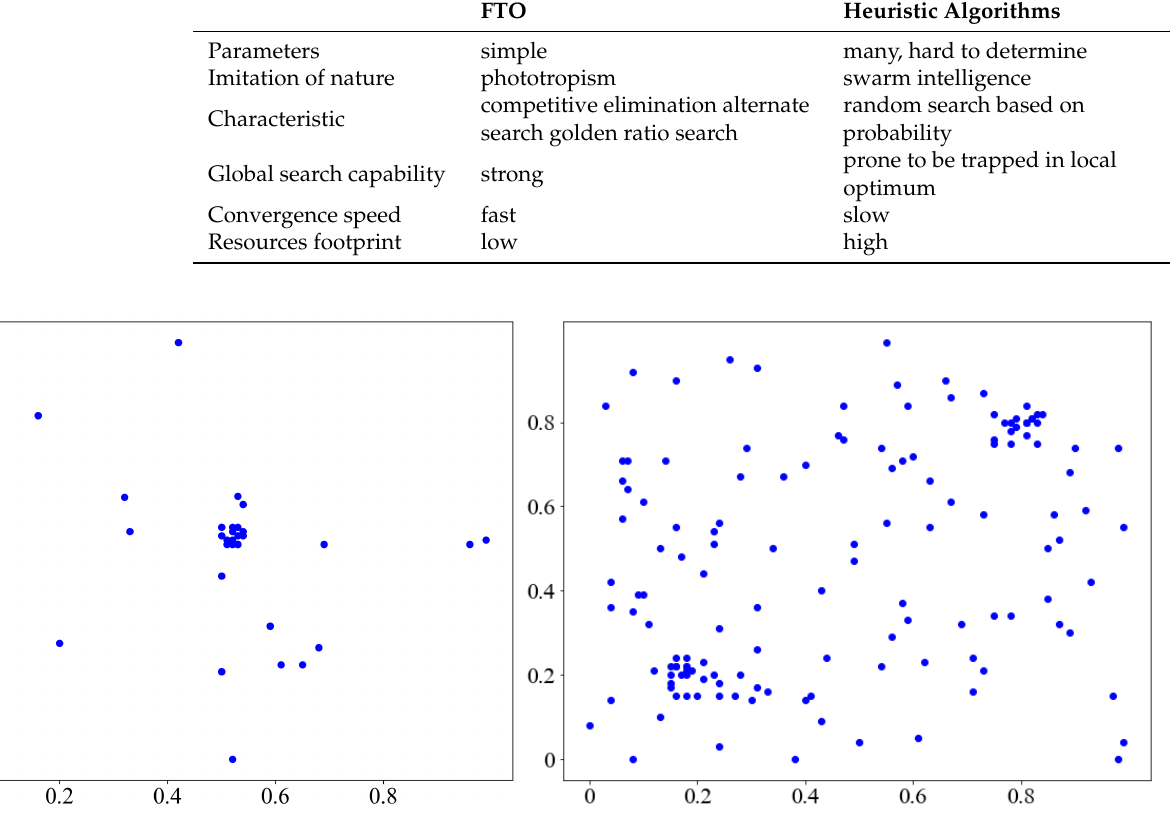
( b ) Global/local alternate search in FTO (cid:16) (cid:17) 2 3 + (cid:0) 9 x 2 + 9 y 2 (cid:1) 2 , and 0.05 + 9 x 2 + 9 y 2